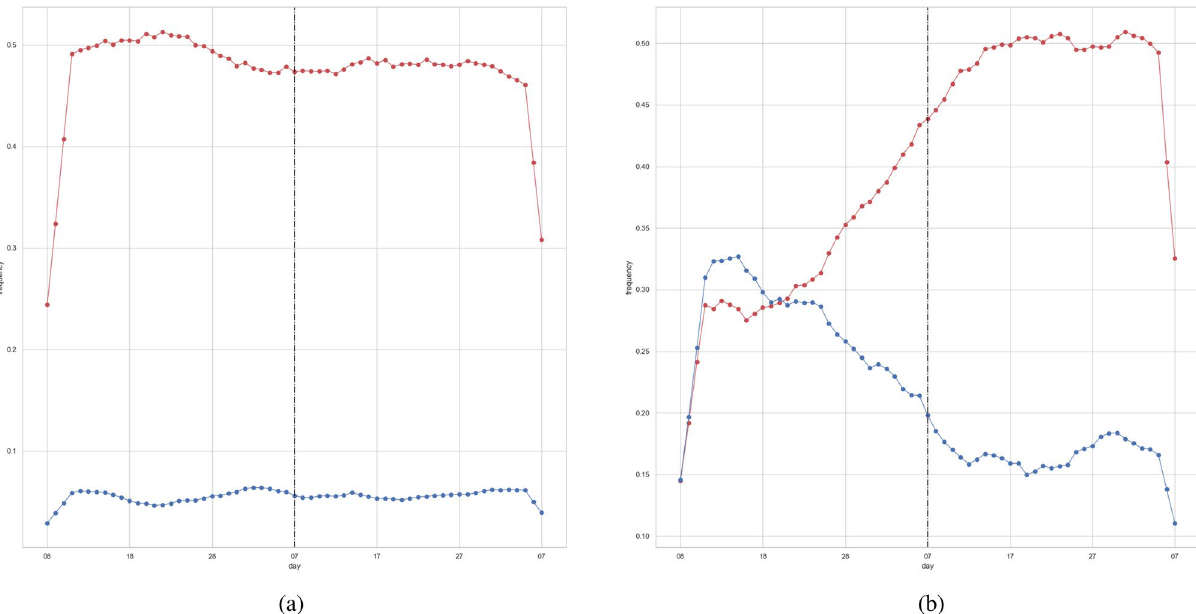
Figure 8. Time series signals for each cluster. The first and second trend clusters are denoted by red and blue, respectively. We show the averages of all trends in each cluster. The vertical line indicates the day of the state- of-emergency declaration (April 7, 2020). Although Tables 4 and 5 show the average and standard deviation over 10 trials, these figures show results for one trial. ( a ) Results for k -shape 32 . ( b ) Results for k -shape 32 with the graphical lasso algorithm 22 .